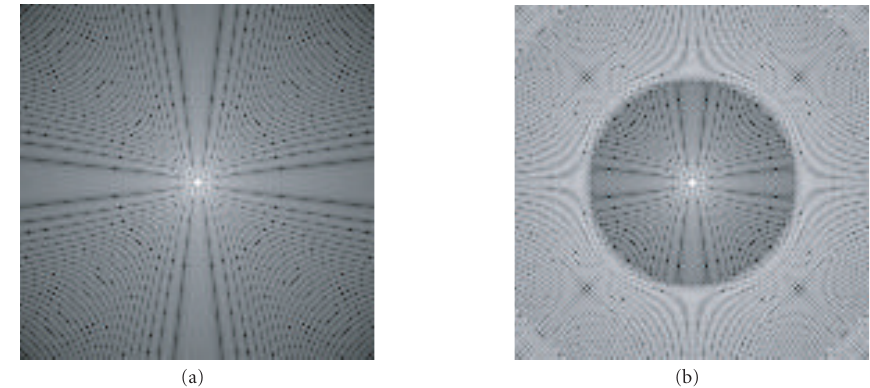
Figure 2: Point spread functions of well-sampled and undersampled radial scans in dB scale. (a) PSF of well-sampled case. (b) PSF of 70% undersampled